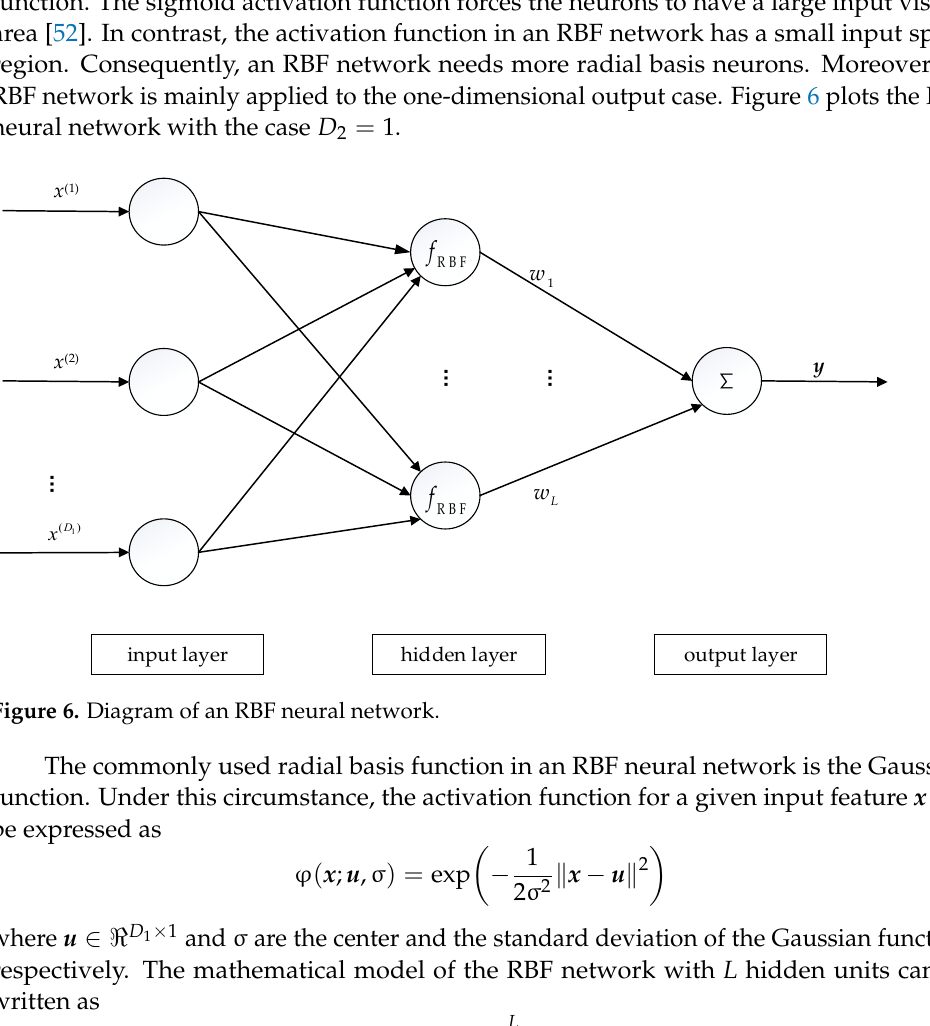
Figure 5. Diagram of a BP neural network with a single hidden layer.